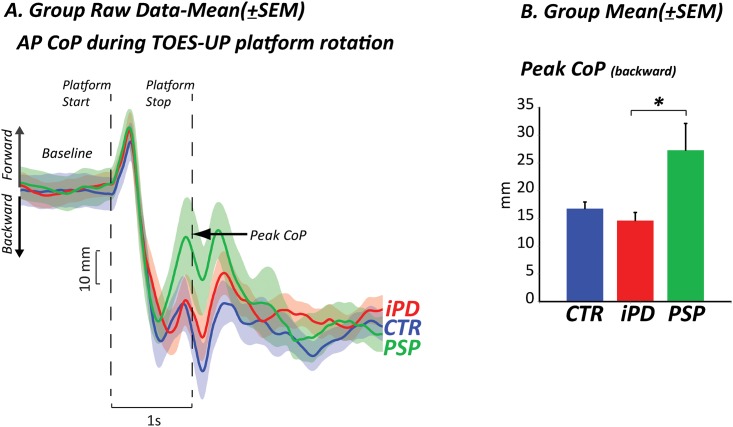
Postural motor control: Toes-up platform rotation.CoP: center of pressure displacement A) Group raw data mean±SEM and B) Group mean±SEM, CoM: center of mass.